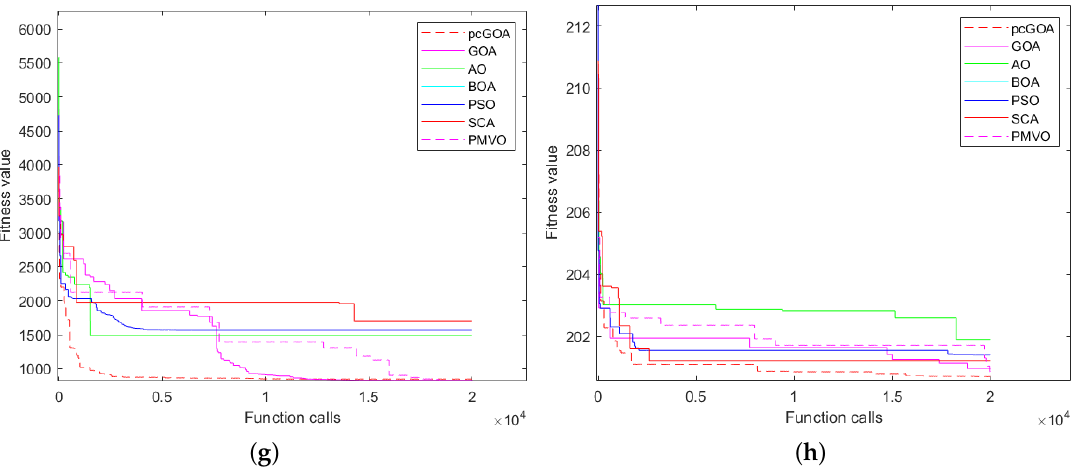
Figure 4. The convergence trend of the multi-modal state of the benchmark function in CEC2013.